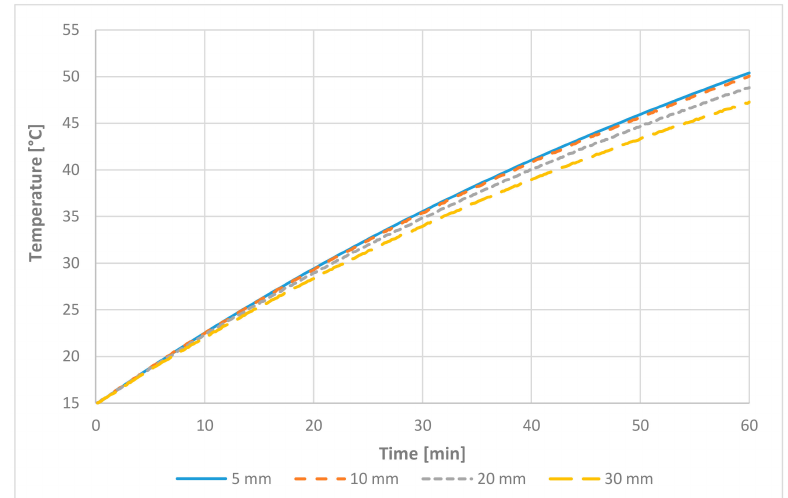
Figure 3. Temperature evolution of the tank for di ff erent mesh refinements (size of element side).